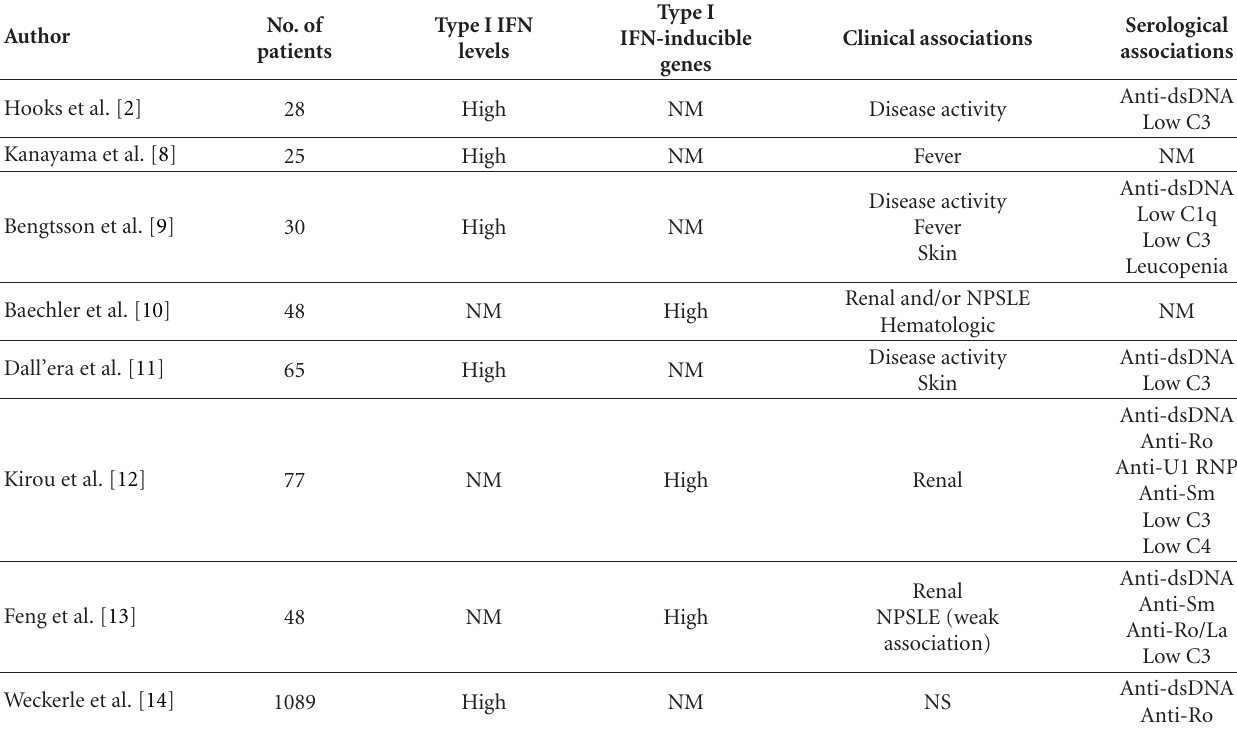
Table 1: Studies in patients with SLE showing statistical significant associations ( P < 0 . 05) between peripheral type I IFN activity and clinical and serological